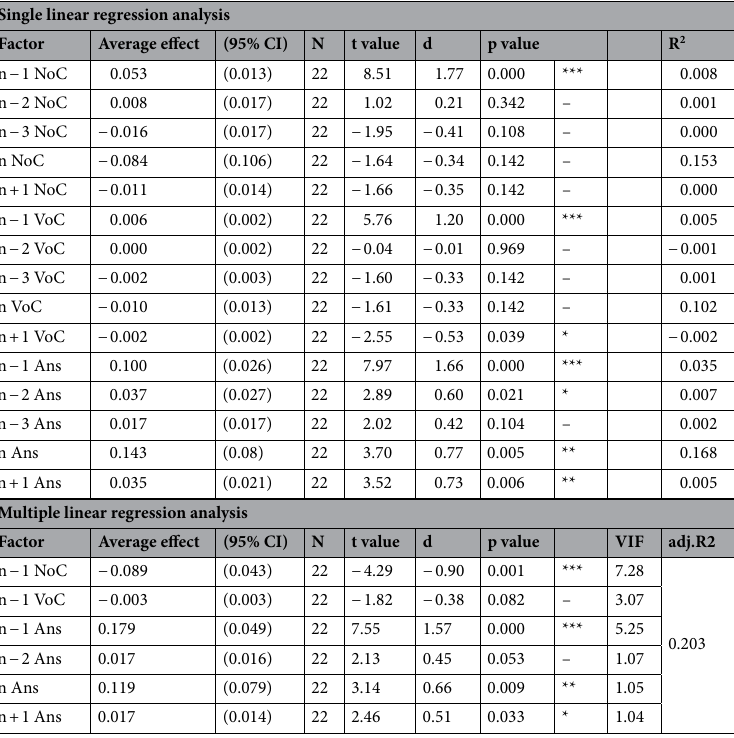
Table 1. Summary of single and multiple regression analyses for Experiment 1. NoC indicates the number of coins, VoC indicates the monetary value of coins, and Ans indicates the participant’s